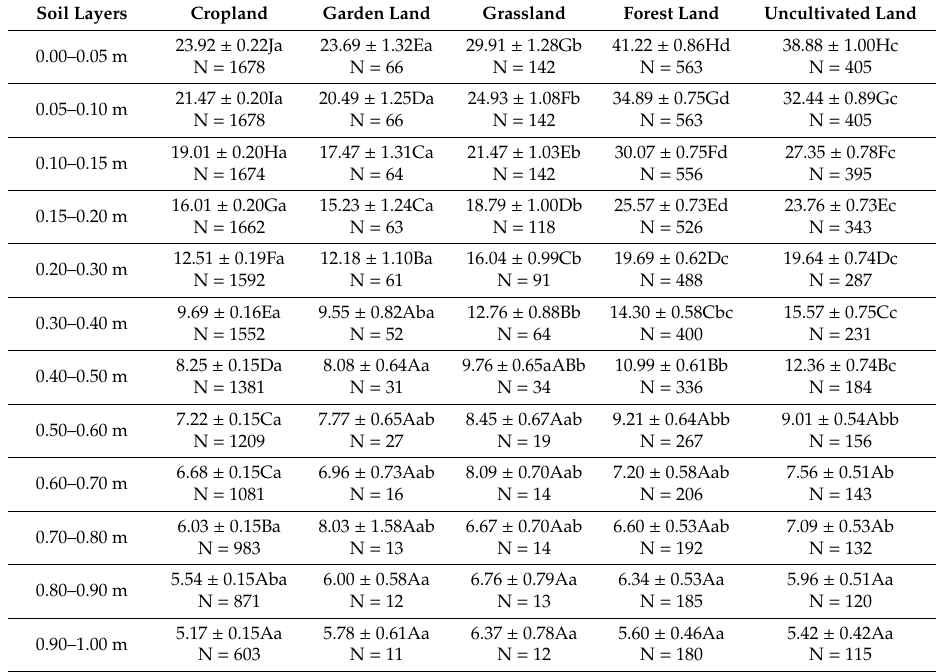
Table 2. Profile characteristics of the soil organic carbon (SOC) concentrations for different land uses (g kg − 1 ). Soil